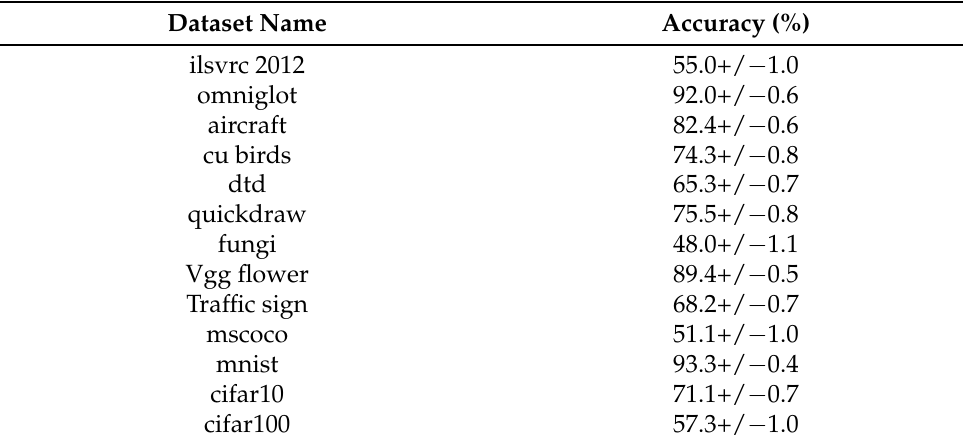
Table 2. LFM-CNAPS test accuracy on the